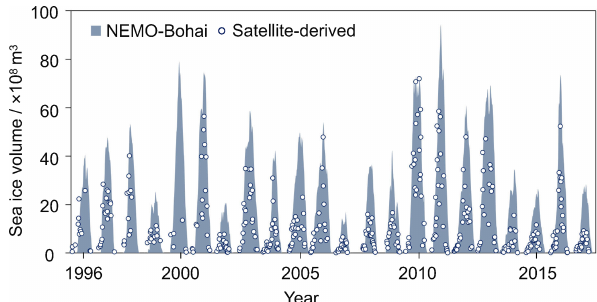
Figure 10. The comparison of sea ice thickness between the sim- ulated and observation data in the Bohai Sea. The vertical red bars represent the range of the observations, while the blue triangles de- note the simulations based on NEMO-Bohai.